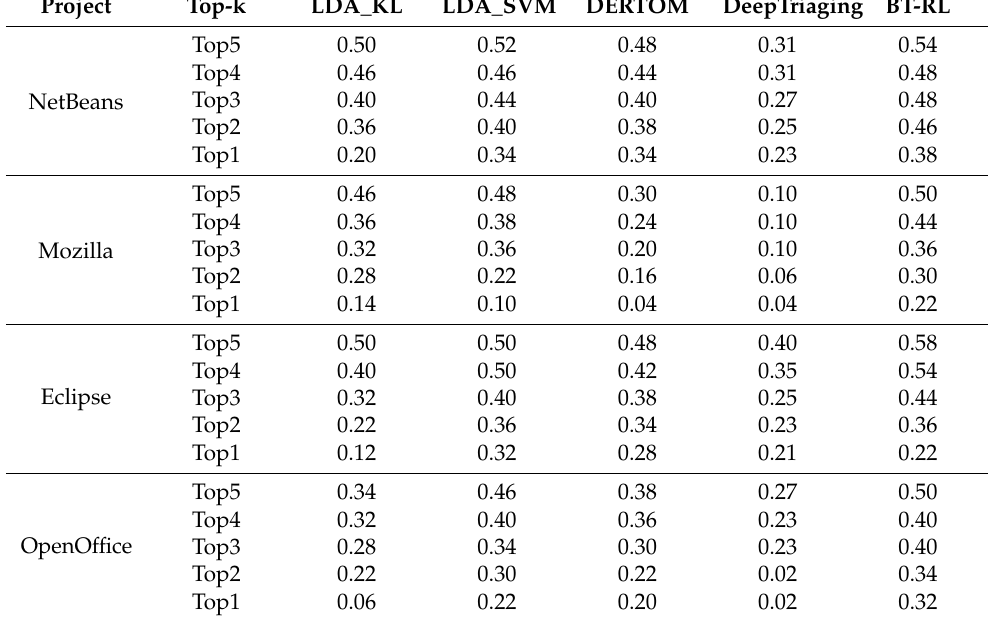
Table 5. The accuracy of BT-RL and other benchmarks on four projects of the third experimental window. Project Top-k LDA_KL LDA_SVM DERTOM DeepTriaging BT-RL